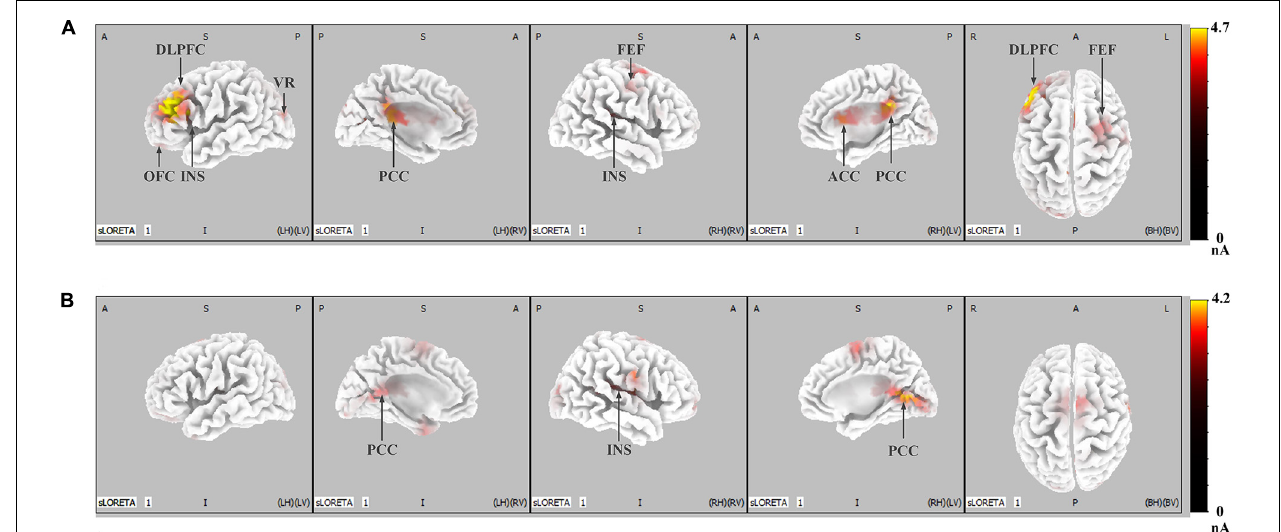
FIGURE 5 | LORETA probabilistic map in cortical difference of activation between IRA engendered and IRA un-engendered conditions, both at the LPP (A) and the P300 (B) . Red colors represent a greater activation in IRA engendered condition, more evident from dark red to yellow.